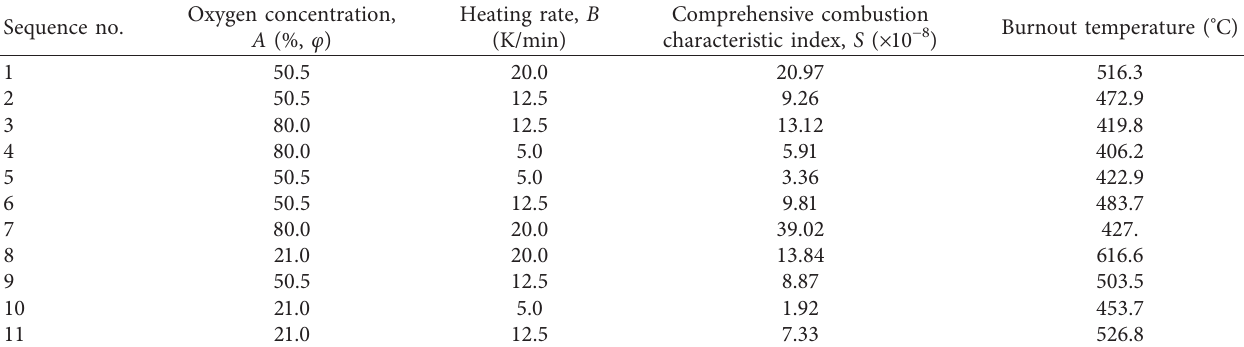
Table 1: Miscellaneous design and evaluating indicator.